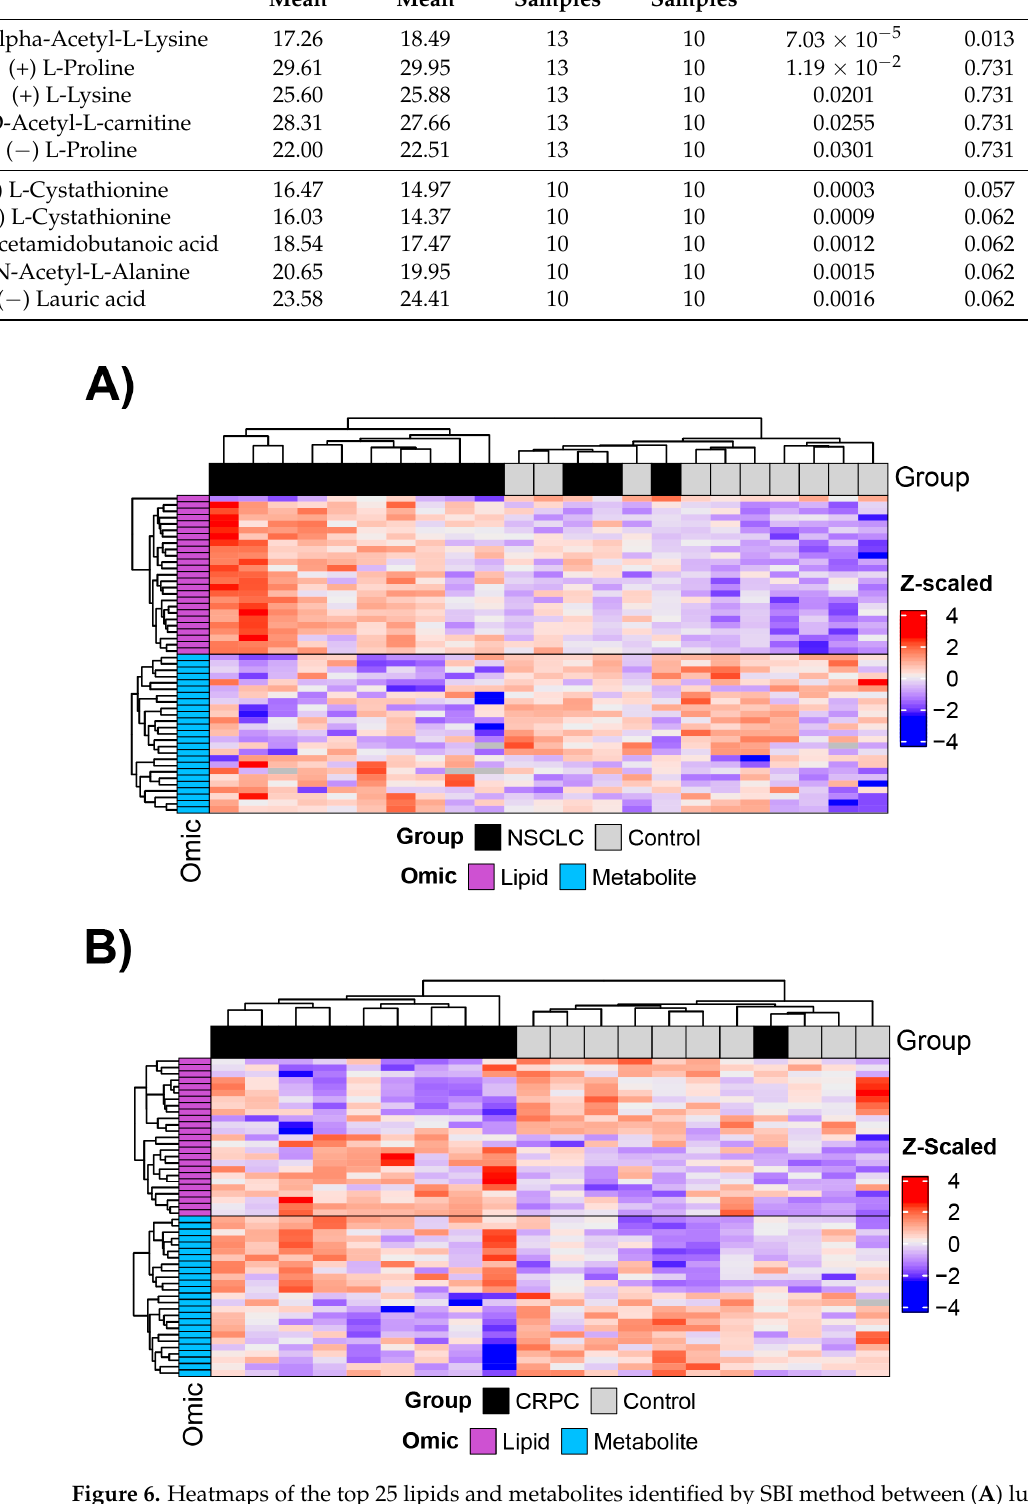
Figure 6. Heatmaps of the top 25 lipids and metabolites identified by SBI method between ( A ) lung cancer samples and healthy controls and ( B ) prostate cancer samples and healthy controls.